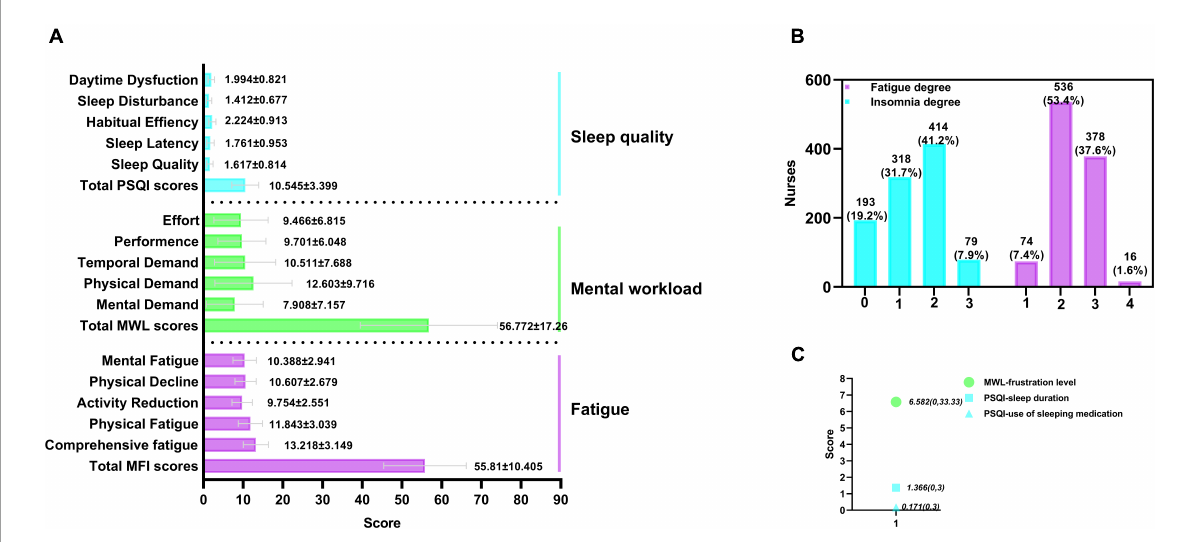
FIGURE2 Distribution of total scores of three scales and their component scores ( n = 1004). MFI, multiple fatigue impact scale; PSQI, the Pittsburg Sleep Quality Index; MWL, the NASA task load index; 0, normal; 1, minor; 2, serious; 3, severe; 4, extremely severe. (A) Distribution of total scores of MFI, MWL, and PSQI, and their component scores. (B) Percentage of the degree of insomnia and fatigue. (C) Analysis of the component score of MWL and PSQI [(mean, (max, min)], which did not conform to the normal